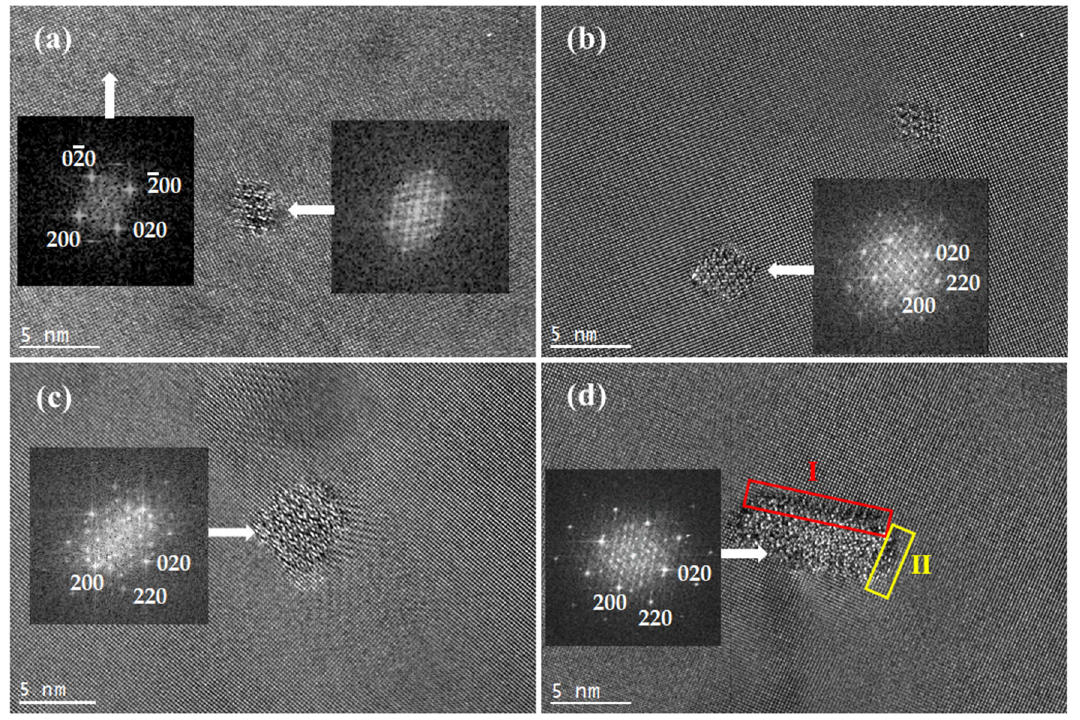
Figure 3. HRTEM image of precipitates and their FFT images, [ 001 ] Al ( a ) aged for 2 h; ( b ) aged for 9 h; ( c ) aged for 12 h; ( d ) aged for 12 h.